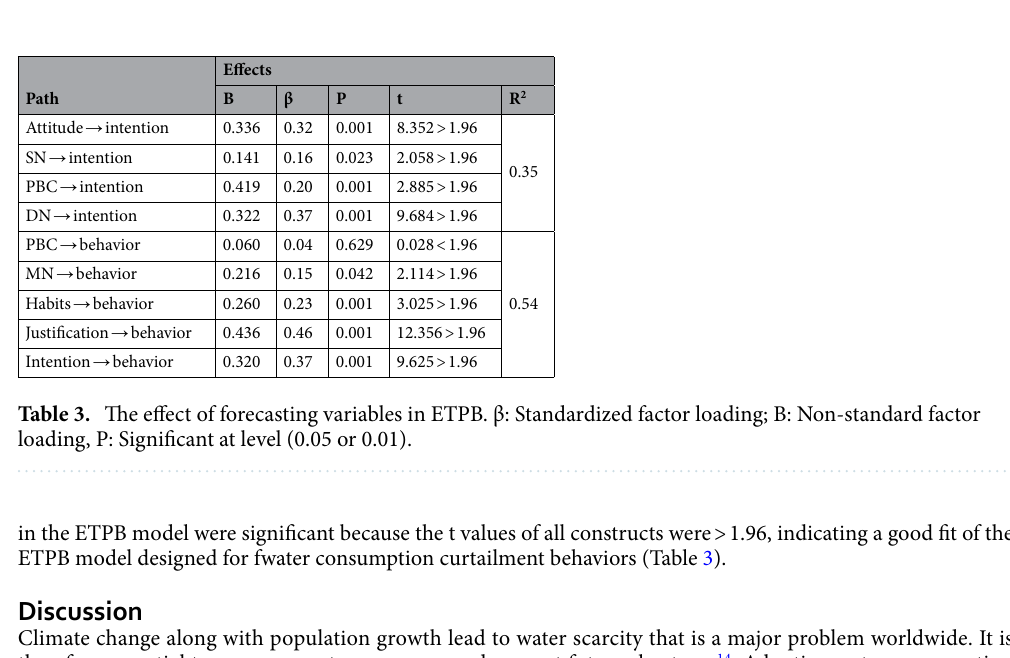
Figure 3. Structural path model. *Significant at the level of 0.05; **Significant at the level of 0.01; ns No significant level.